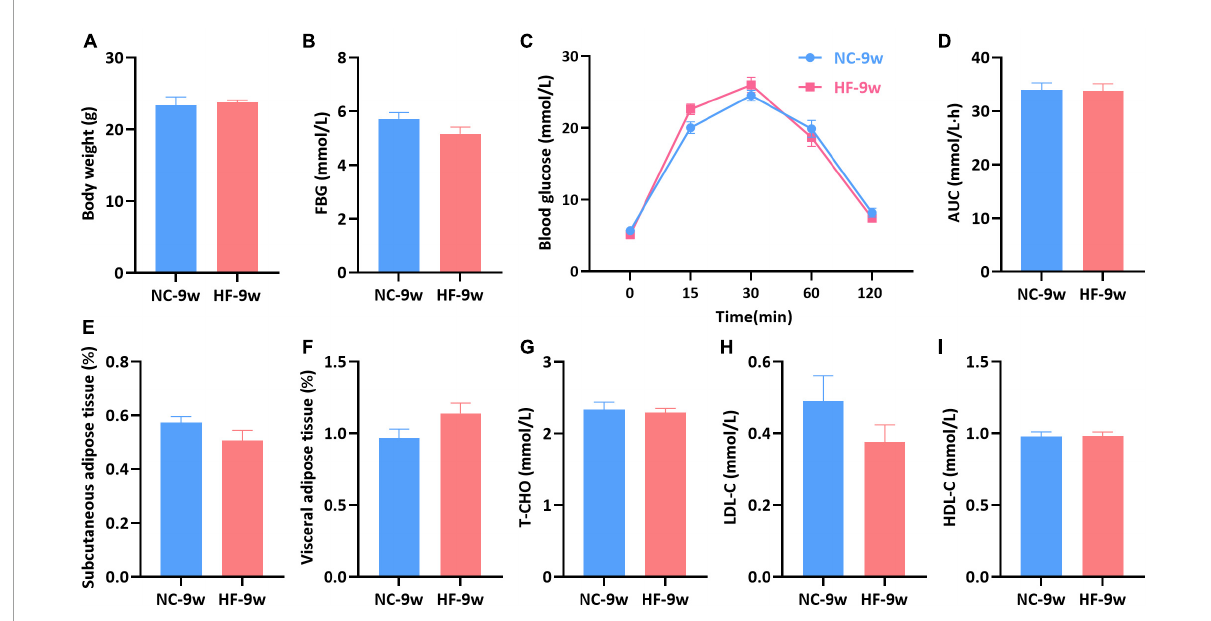
FIGURE6 Glycolipid metabolism disturbance induced by the maternal HF diet was recovered in offspring at 9 weeks of age. (A) Body weight. (B) FBG. (C) IPGTT. (D) AUC. (E) Subcutaneous adipose tissue. (F) Visceral adipose tissue. (G) Serum T-CHO. (H) Serum LDL-C. (I) Serum HDL-C. Data are represented as the mean ± SEM (NC-9w, n = 8; HF-9w, n = 8). NC, normal chow diet; HF, high-fat diet. IPGTT, intraperitoneal glucose tolerance tests; AUC, the area under the glucose curve; FBG, fasting blood glucose; T-CHO, total cholesterol; LDL-C, low-density lipoprotein cholesterol; HDL-C, high-density lipoprotein cholesterol.